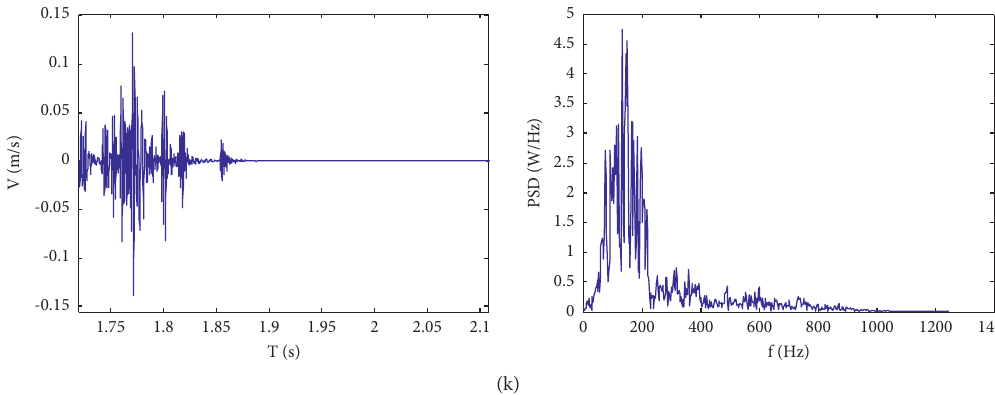
Figure 4: Waveforms and the power spectral density curves for each detonator: (a) MS1 signal curve and power spectrum density; (b) MS3 signal curve and power spectrum density; (c) MS5 signal curve and power spectrum density; (d) MS7 signal curve and power spectrum density; (e) MS8 signal curve and power spectrum density; (f) MS9 signal curve and power spectrum density; (g) MS10 signal curve and power spectrum density; (h) MS11 signal curve and power spectrum density; (i) MS13 signal curve and power spectrum density; (j) MS15 signal curve and power spectrum density; (k) MS15 signal curve and power spectrum